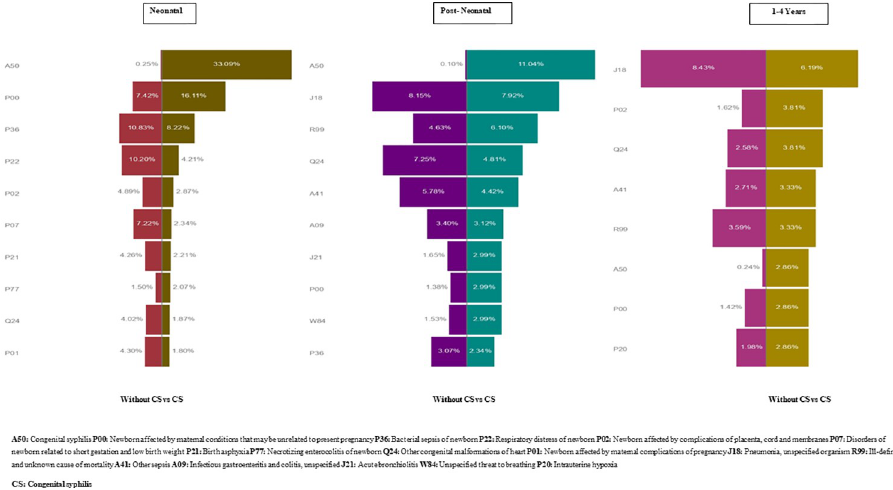
Fig 1. Underlying cause of deaths using ICD-10 codes by age group and CS status. AU : AbbreviationlistshavebeencompiledforthoseusedinFig 1 andTable 1 : Pleaseverifythatallentriesarecorrect : Among children with CS, infections specific to the perinatal period and hematological disorders were more than twice as common as they were among children without CS during the neonatal period. During the postneonatal period, HIV, noxious substances transmitted via placenta or breast milk, anemia, and specific external causes were more than twice as common as they were among children without CS. Among children 1 year or older, bacterial meningitis and paralytic ileus and intestinal obstruction were more than twice as common as they were among children without CS. Similar to the postneonatal period, among older children with CS, specific external causes (events of undetermined intent and accidental threats to breathing) were more than twice as common as they were among children without CS (S2 Fig). CS, congenital syphilis; ICD, International Classification of